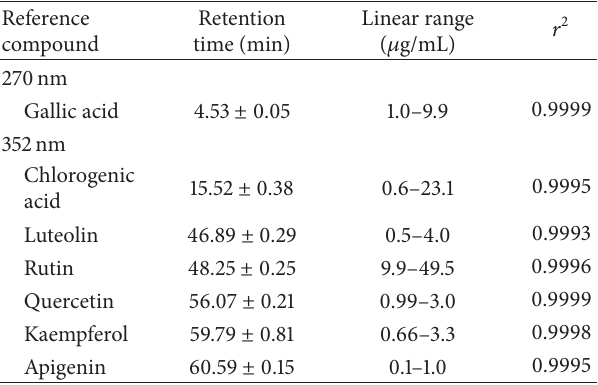
Table 3: Elution order of polyphenolic compounds separated by HPLC-DAD.